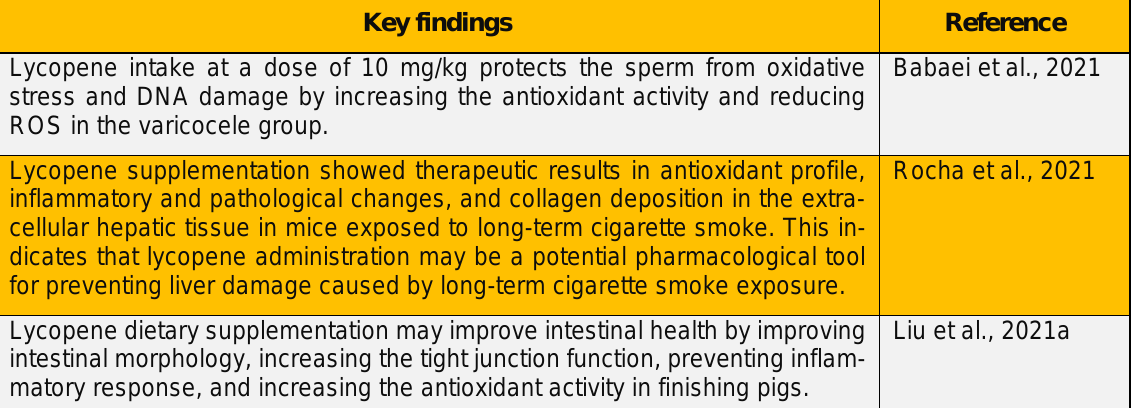
Table 1: Recent studies on the biological and pharmacological activities of lycopene Key